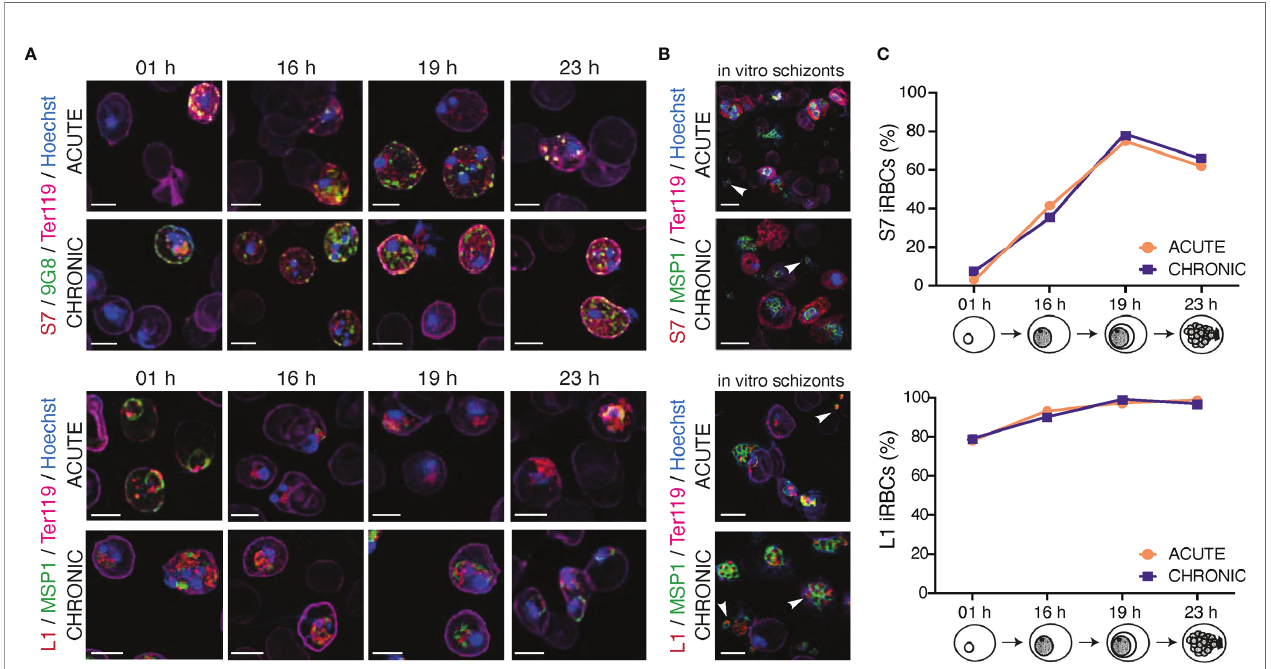
FIGURE 3 | Localisation pattern of S7 and L1 PIRs across the 24-hour asexual blood cycle of MT P. c. chabaudi AS parasites, during the acute- and chronic- phases of infection. (A, B) Immuno fl uorescence assays of MT WT P. chabaudi parasites at different developmental stages of their asexual blood cycle. WT mice were directly exposed to infected mosquitoes and following infection establishment, acute- (at day-7 post infection) or chronic-phase (at day-45 post infection) parasites were passaged into C57Bl/6 RAG1 -/- mice. Upon infection establishment, blood tail smears were prepared for immuno fl uorescent staining at the ring (1 h), early trophozoite (16 h), mature trophozoite (19 h) (A) , and late trophozoite/schizont (23 h) (B) developmental stages. Blood smears from in vitro schizont cultures, following fi ve hours of culture, were also prepared. Parasites were primarily stained with the anti-S7 (top panels) or anti-L1 peptide sera (bottom panels) (red). S7- incubated slides were then probed with the anti-clone 6 (9G8) (green) antibody, whereas L1-incubated slides were probed with the anti-MSP1 monoclonal antibody (green). The RBC surface membrane was stained with an anti-Ter119 antibody (magenta), and parasite nuclei were stained with Hoechst (blue). Images were taken from confocal sections of acetone:methanol fi xed parasites at X630 magni fi cation. Asterisks indicate free merozoites. Scale bar length correspond to 5 m m. (C) Percentage of S7-positive (top panel) and L1-positive (bottom panel) iRBC throughout the 24-hour life cycle, in MT parasites during acute- and chronic-phases of infection. About 950-1,000 red blood cells were analysed across two individual biological replicates, where data are presented as